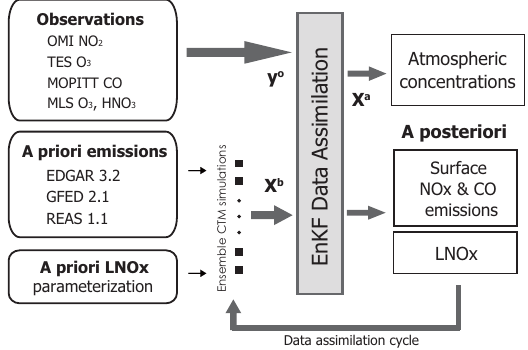
Fig. 1. Schematic diagram of the data assimilation system. The en- semble model simulation with a priori emissions is used to provide the background error covariance information ( X b ). The data assim- ilation is performed using the background error information and the observation information ( y o ). Then the data assimilation provides a posteriori estimates of surface NO x emissions, surface CO emis- sions, lightning NO x emissions, and 3-D distributions of the chem- ical species ( X a ). Assimilation of MLS O 3 and HNO 3 data affects the concentrations only above 260 and 220hPa, respectively. O x is the sum of O 3 and O ( 1 D ) , and NO x is the sum of NO, NO 2 , and NO 3 . See Sect. 3 for